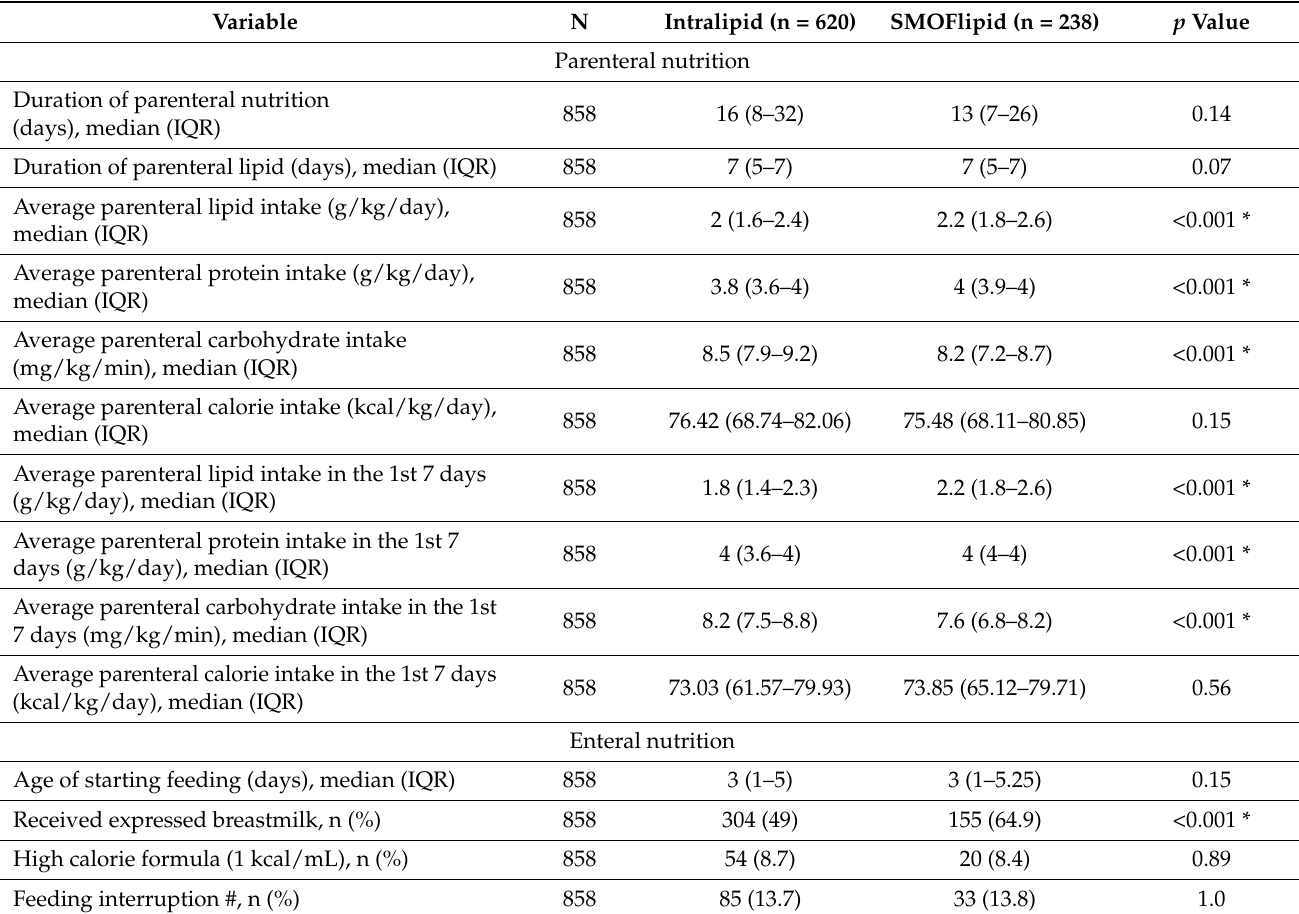
Table 2. Nutritional and growth characteristics of study participants with SMOFlipid and